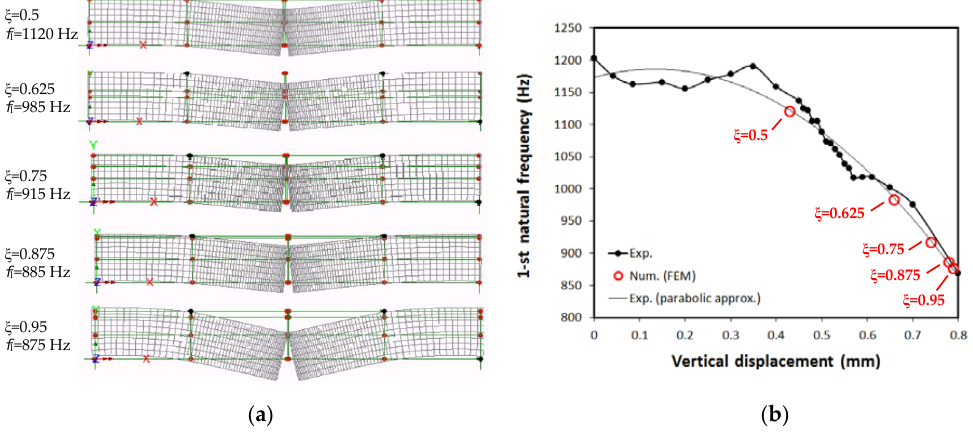
Figure 11. ( a ) Numerical (FEM) fundamental vibration mode and frequency of the unloaded beam for increasing notch depth ( ξ = a / h ) and ( b ) approximate evaluation of crack advancement based on measured and calculated (FEM) fundamental frequencies.